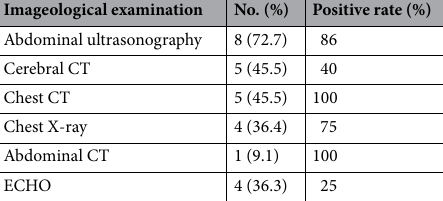
Table 3. Common imaging scans and its positive detection